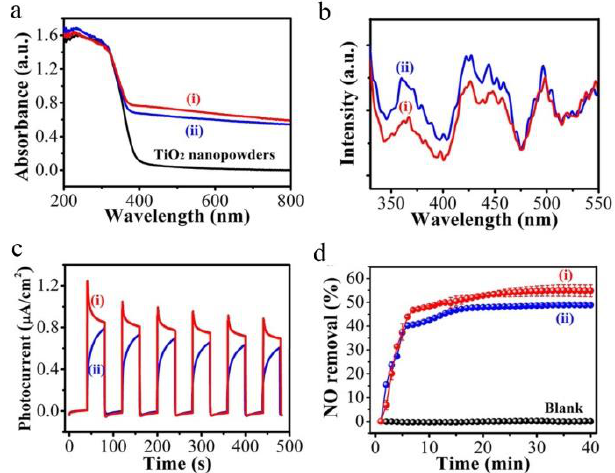
Figure 17. ( a ) UV-Vis DRS, ( b ) PL emission spectra, and ( c ) photocurrent intensity of (i) anatase mesocrystals and (ii) anatase nanocrystals of TiO 2 self-doped with Ti 3+ . ( d ) Visible-light-driven photodegradation of NO upon (i) anatase mesocrystals and (ii) anatase nanocrystals self-doped with Ti 3+ . Reprinted with permission from [150]. Copyright John Wiley & Sons Inc., 2017.